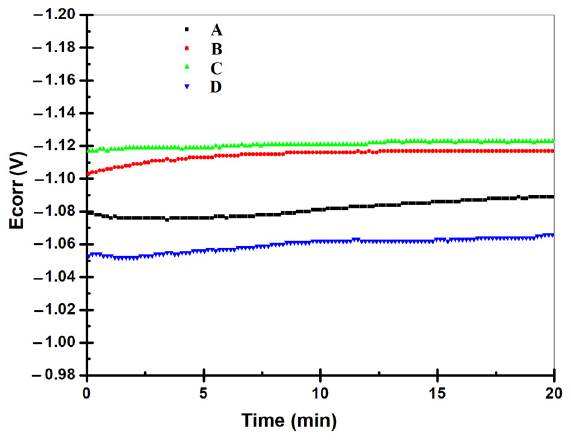
Figure 8. Open circuit potential measurements of the tested samples.